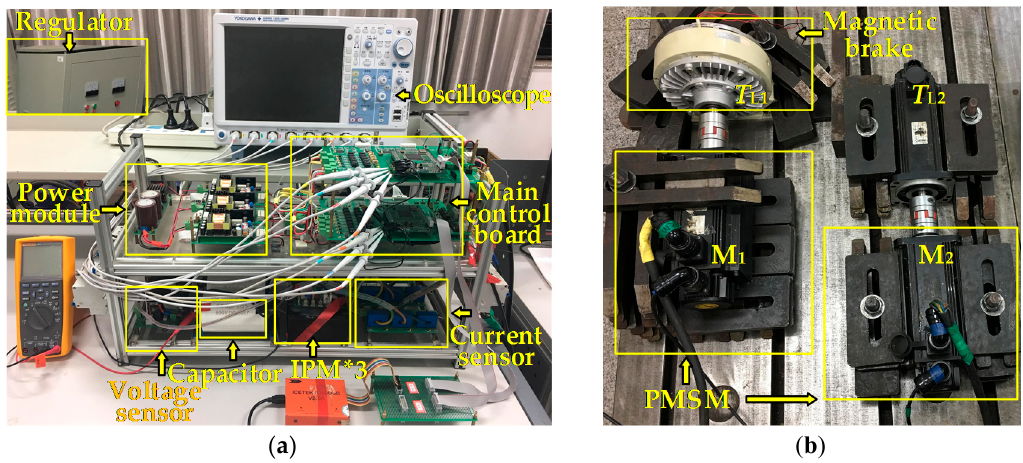
Table 3. Experiment parameters of permanent magnet synchronous motors (PMSMs).